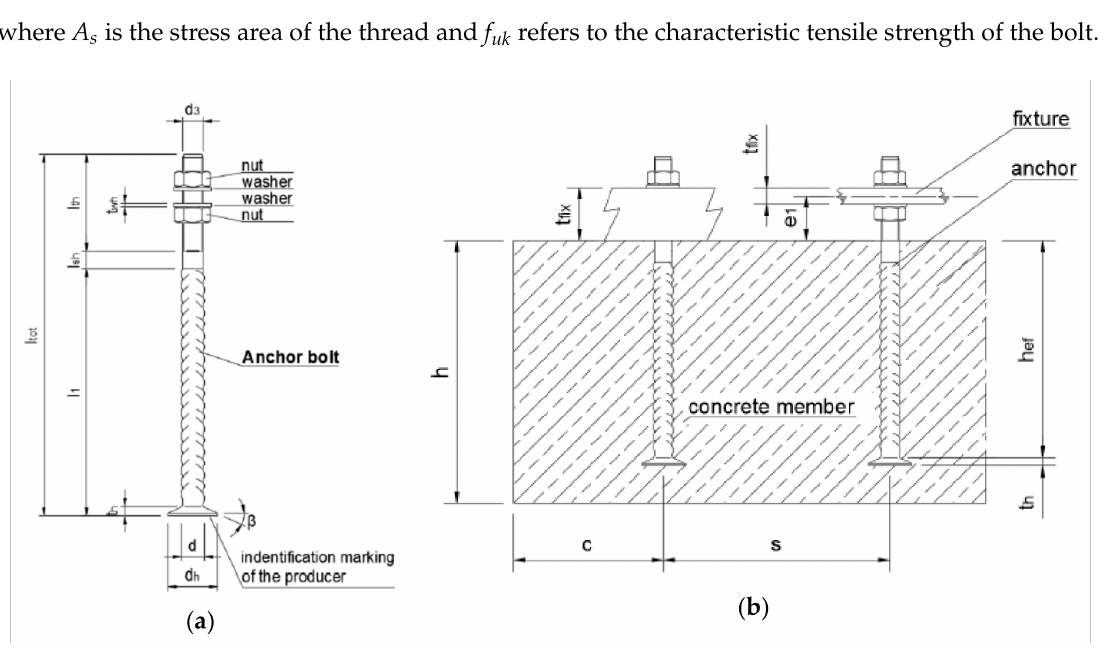
Figure 1. Anchor system: ( a ) Anchor bolt and ( b ) use of anchor